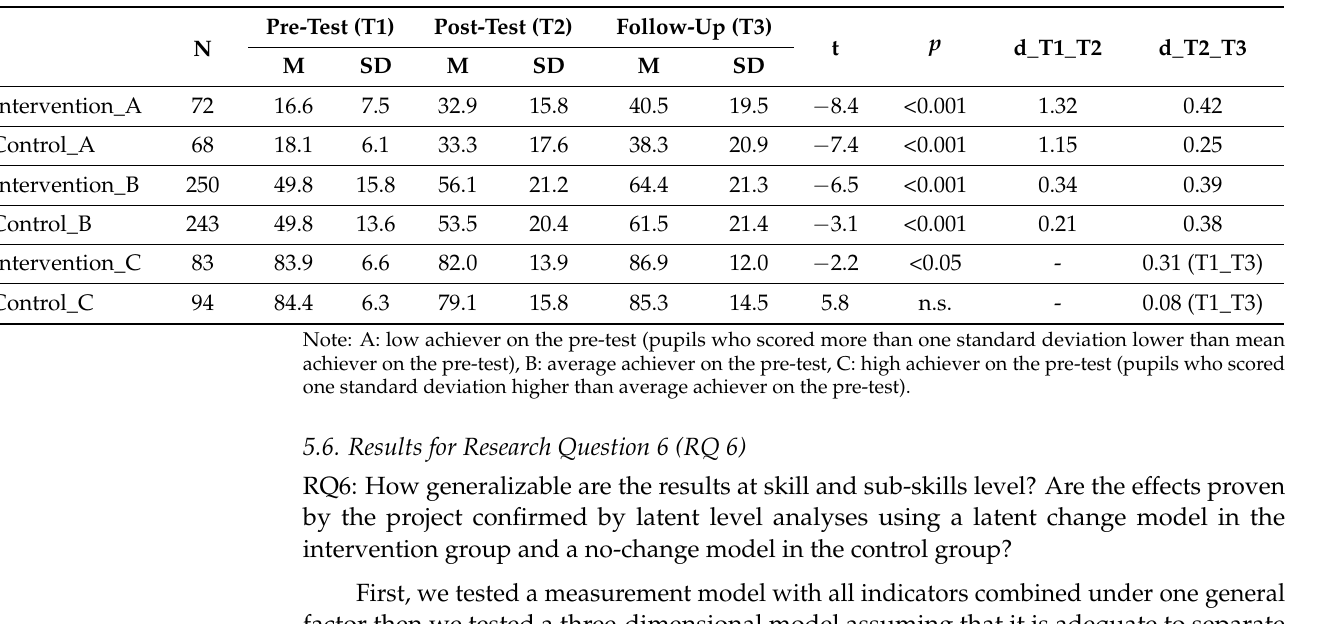
Table 6. Change in performances according to performance-based groupings (in terms of Cohen’s-d) in pre-, post- and follow-up